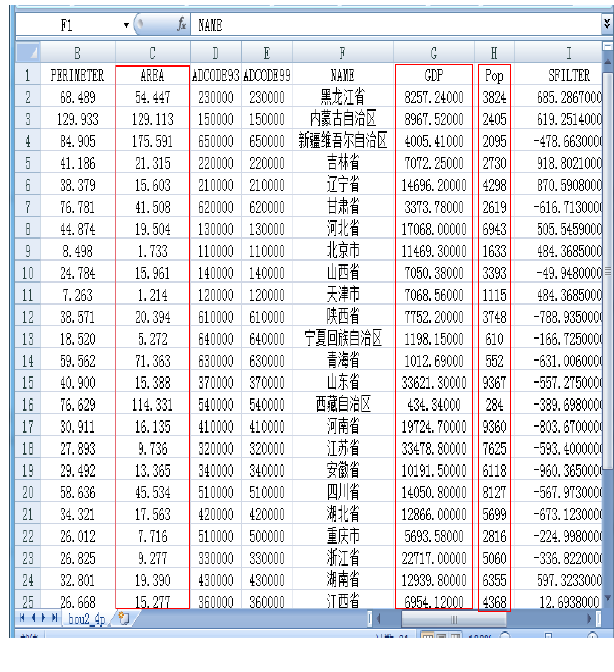
Figure 6. Experiment data